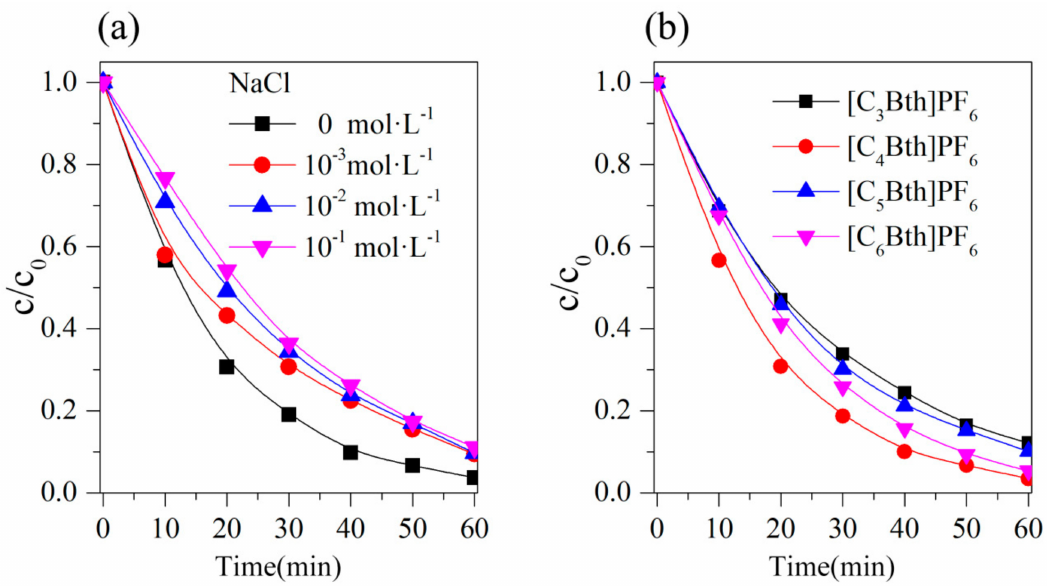
Figure 5. E ff ect of chloride ion concentration on degradation ( a ) and carbon chain length of ILs ( b ) on degradation; [IL] = 0.1 mM, t = 45 °C, [H 2 O 2 ] = 100